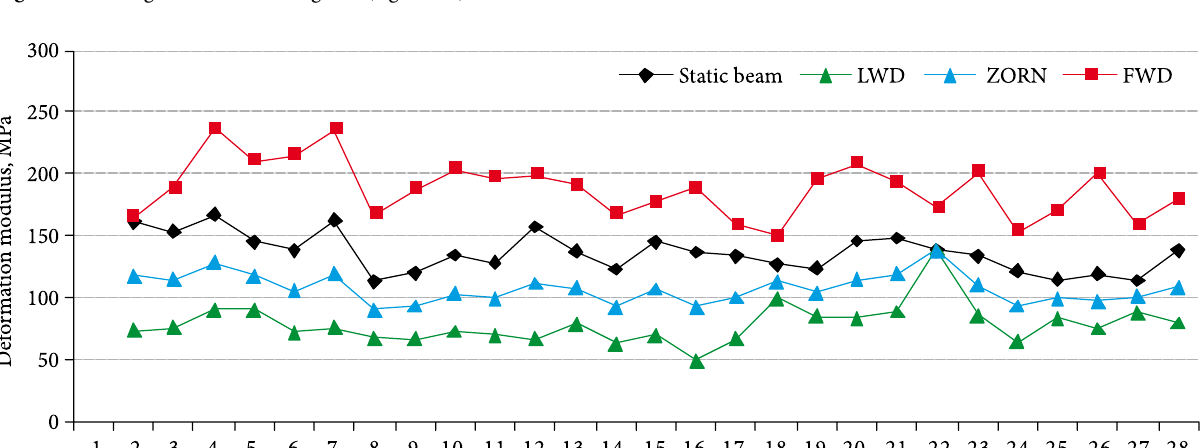
fig. 8. Measuring results of frost blanket course (left